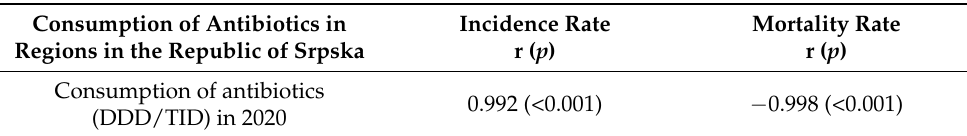
Table 5. Correlation between consumption of antibiotics among outpatients and crude COVID-19 incidence and mortality rate in 2020 in the Repbublic of